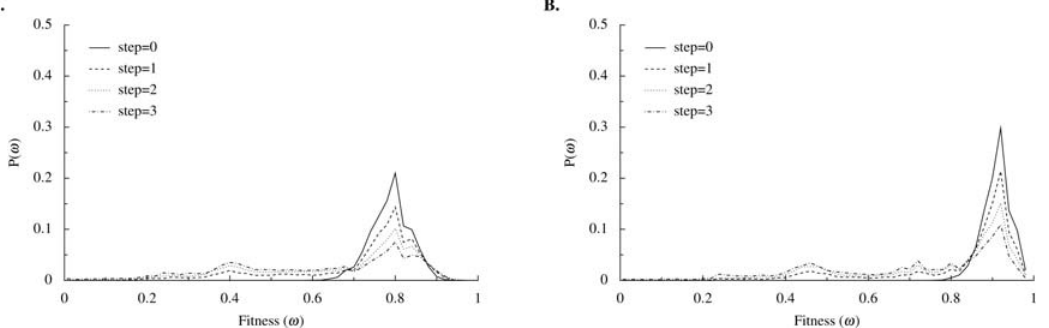
Figure 13. Fitness of evolved networks in noisy environments. Frequency distributions of fitness for single evolved networks subjected to 10,000 trials in a noisy environment. Solid lines indicate the fitness of the evolved network, while dashed lines indicate the fitness of networks that are 1, 2, or 3 mutational steps away from the evolved network. (A) Fitness of the network produced by evolution in a stable environment. (B) Fitness of the network produced by evolution in a noisy environment.